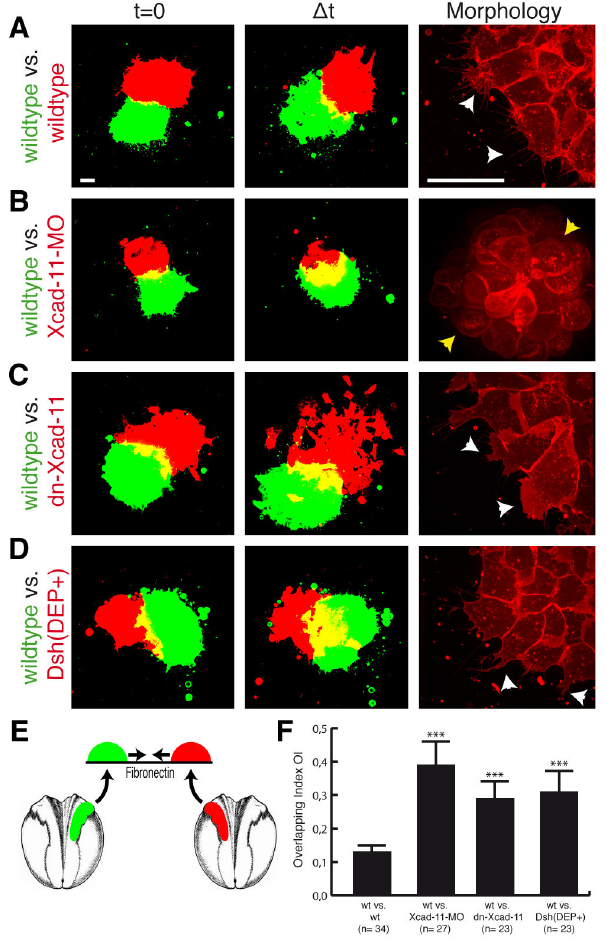
Figure 3. Loss of Xcad-11 adhesive function increases CNC invasiveness in vitro .